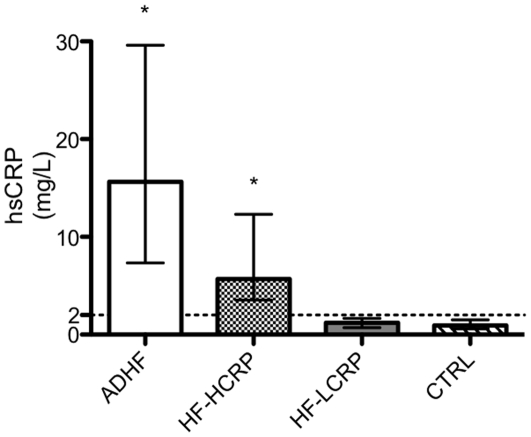
Plasma high sensitivity C-reactive protein (hsCRP).Blood samples were collected from patients from acute decompensated HF (ADHF), HF with high hsCRP (HF-HCRP), HF with low hsCRP (HF-LCRP), and healthy control patients (CTRL) without any cardiovascular disease. High hsCRP was defined as>2 mg/L. *P<0.05 versus CTRL.